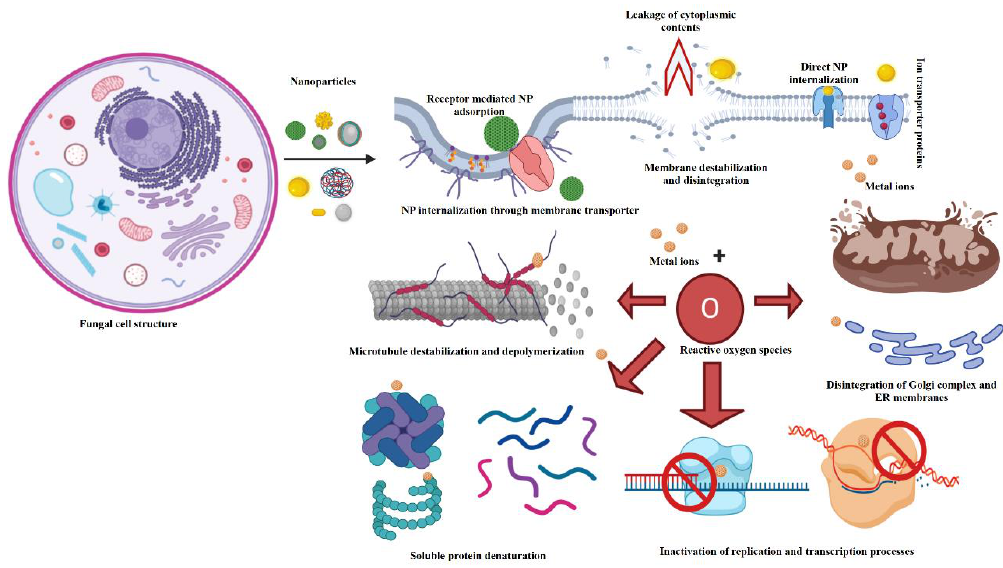
Figure 3. Effect of application of different types of nanoparticles on cellular components and Figure 3. E ff ect of application of di ff erent types of nanoparticles on cellular components and organelles organelles in a fungal cell. in a fungal